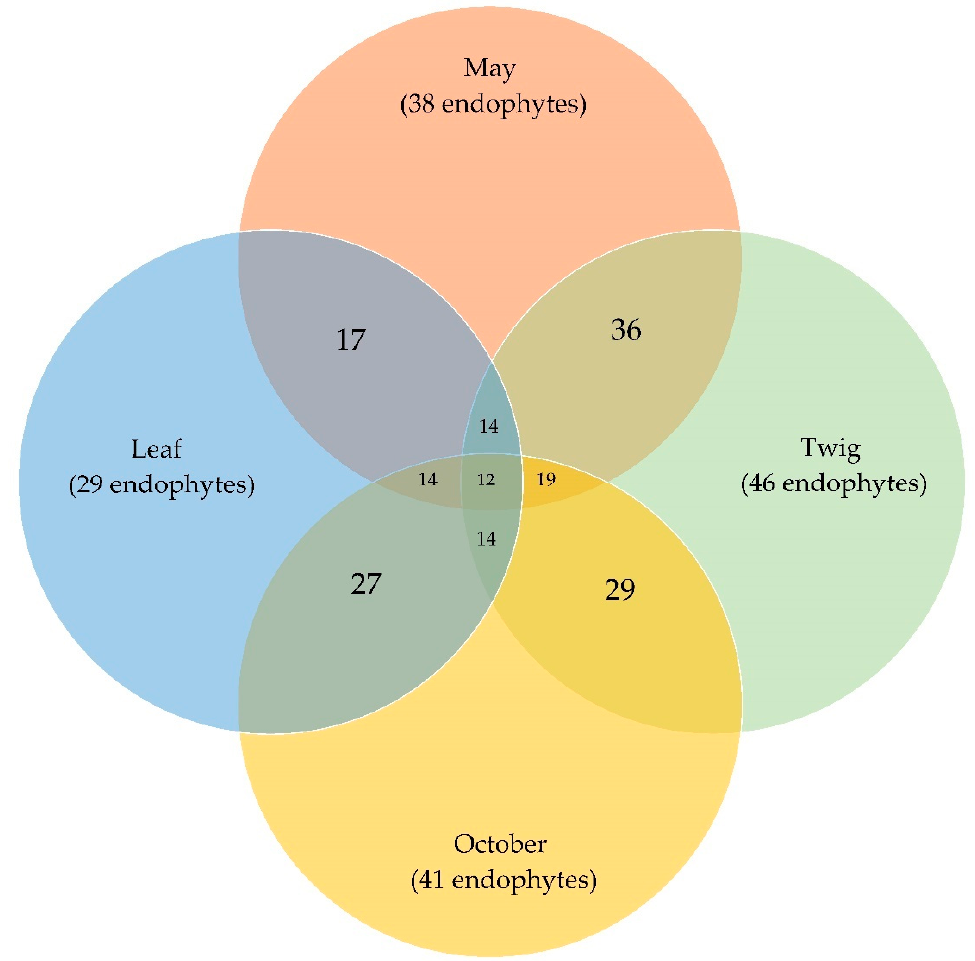
Figure 2. Venn diagram showing the number of identified endophytes shared among different sampling dates (May and October) and tissue locations (leaf and twig) on Fraxinus excelsior . The species diversity indices calculated for all samples in May reached 0.925 and 3.152 for Simpson’s (D) and Shannon’s (H) indices, respectively, and they were similar to the indices for samples collected in October (D = 0.929; H = 3.232) (Table 2). The highest diversity indices were recorded for endophyte populations in asymptomatic leaves in May (D = 0.934; H = 2.471), and the lowest values were recorded for symptomatic leaves in May (D = 0.722; H =